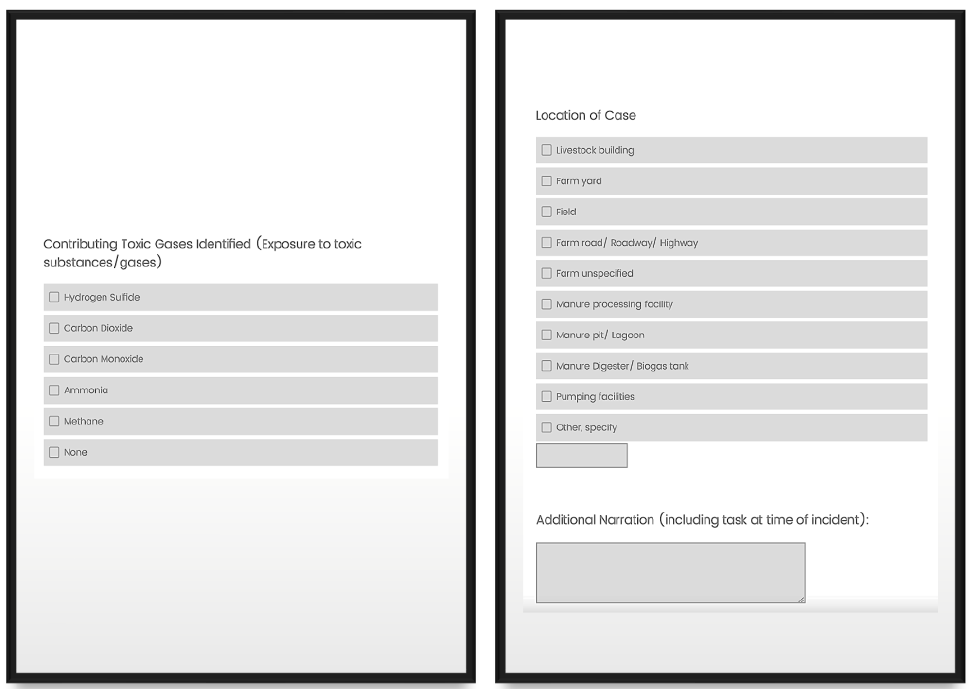
Figure 5. Qualtrics Survey Form: Toxic Gases, Location of Case, Additional info.